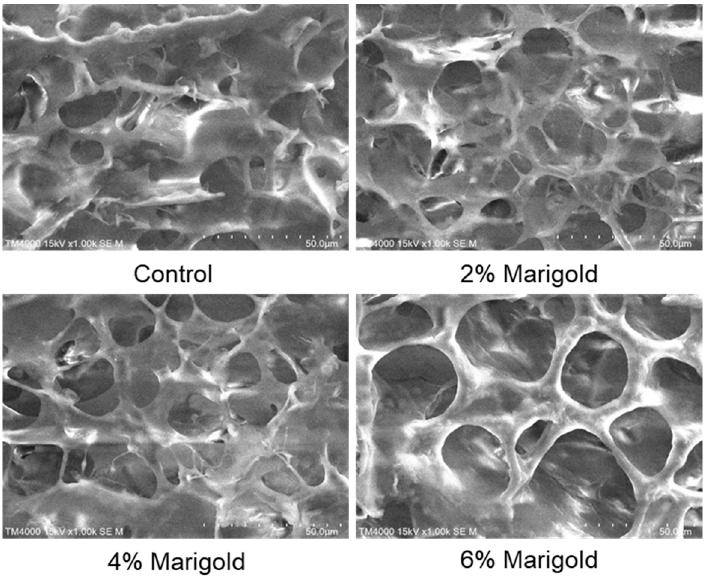
Figure 3. Microstructural changes of wheat flour pastes by marigold powder (×1000 magnifica ‐ tion).